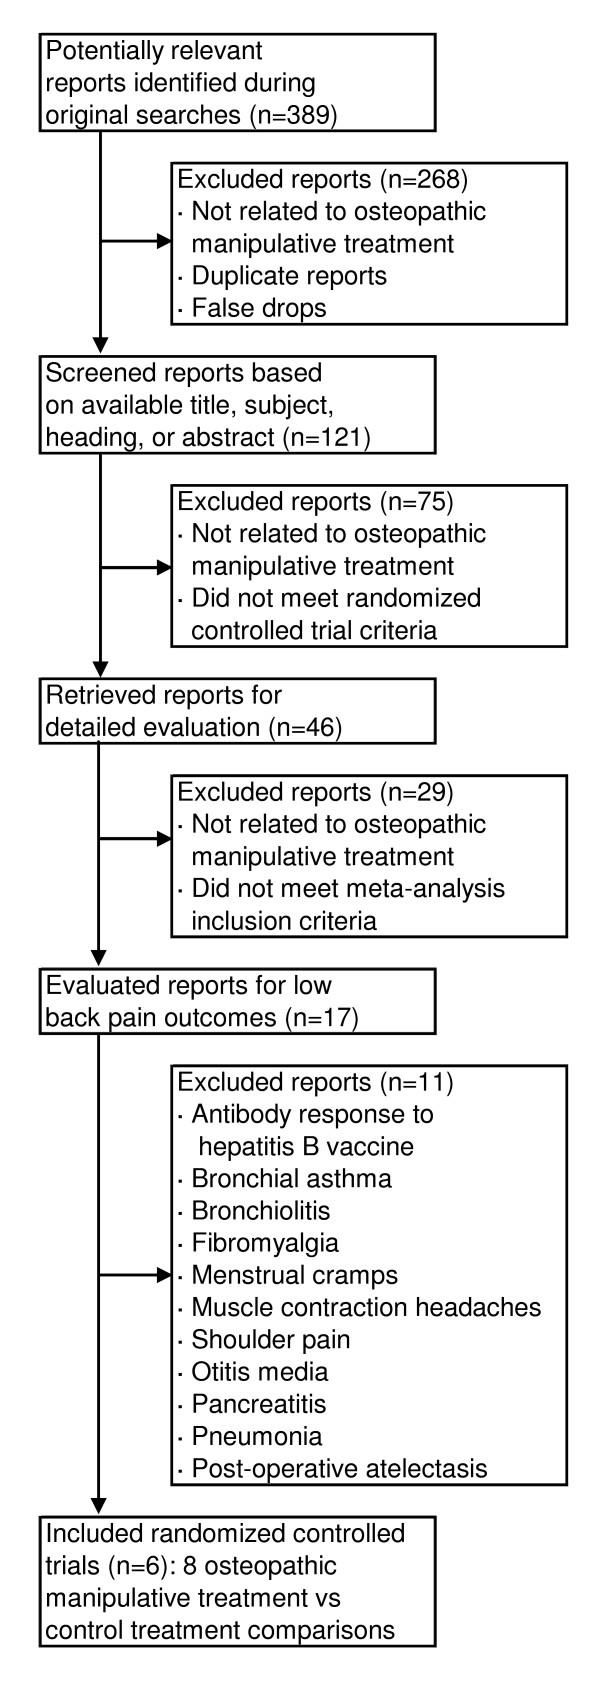
Flowchart of trials.